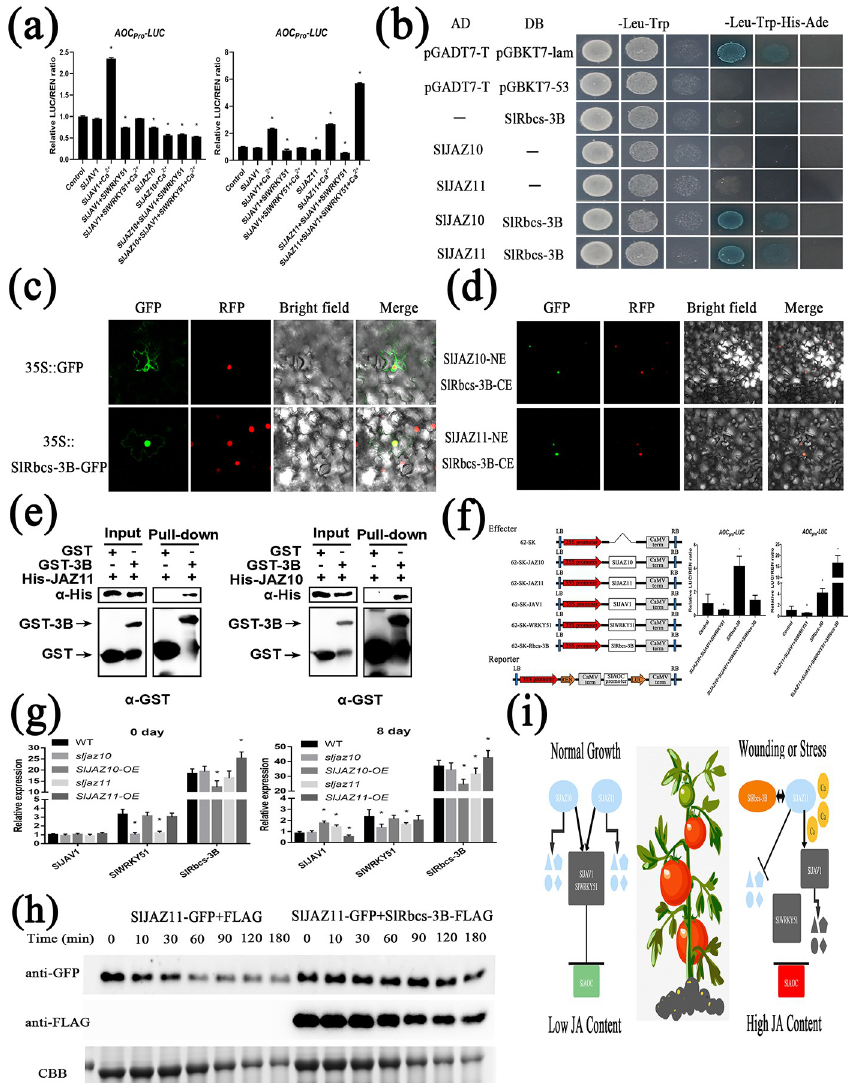
Fig 6. Ca 2+ and SlRbcs-3B inactivates JJW Complex. (a) Ca 2+ alter transcriptional repression of expression. Relative SlJAZ10-SlJAV1-SlWRKY51 and SlJAZ11-SlJAV1-SlWRKY51 complex on the SlAOC Pro -LUC ratio of LUC/REN are means ± SEM (n � 6); � p < 0.01; Student’s t test. (b) Y2H assay shows that SlRbcs-3B interacts with SlJAZ10 and SlJAZ11. (c) Subcellular localization of SlRbcs-3B in the epidermal cells of N . benthamiana leaves. Bars = 40 μ m. (d) BiFC assay confirms the interactions among SlJAZ10, SlJAZ11, and SlRbcs-3B in N . benthamiana leaves. (e) The interaction of His-SlJAZ10 and His-SlJAZ11 with GST-SlRbcs-3B detected by the pull-down assay. GST-SlRbcs-3B was used as bait, and pull-down of His-SlJAZ10 and His-SlJAZ11 was detected by anti-His antibody. (f) SlRbcs-3B alters transcriptional repression of SlJAZ11-SlJAV1-SlWRKY51 complex on the SlAOC Pro -LUC expression. Relative ratio of LUC/REN are means ± SEM (n � 6); � p < 0; Student’s t test. (g) qRT-PCR analysis of transcript levels of SlJAV1 , SlWRKY51 and SlRbcs-3B in dark-treatment leaves of WT, sljaz10 , SlJAZ10-OE , sljaz11 and SlJAZ11-OE plants. Data are means ± SEM (n � 3); � p < 0.01; Student’s t test. (h) SlRbcs-3B promotes maintenance the stabilization of SlJAZ11 proteins in vivo. Proteins were extracted form N . benthamiana leaves transiently expressing SlJAZ11-GFP or SlRbcs-3B-Flag alone. Extracts containing SlRbcs-3B-Flag were incubated with SlJAZ11-GFP or GFP extracts for different times. Degradation of SlJAZ11-GFP was detected by anti-GFP antibody. An equal amount of SlRbcs-3B-Flag or Flag was detected by anti-Flag antibody. The equal amount of protein stained by CBB was used as a loading control. (i) A simplified model for injury-triggered JA biosynthesis in plant defense.